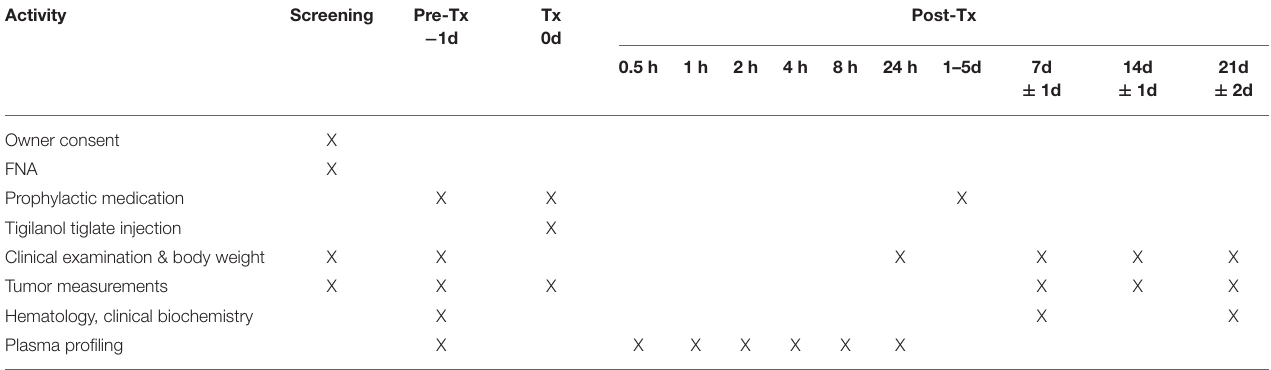
TABLE 2 | Schedule of study activities.